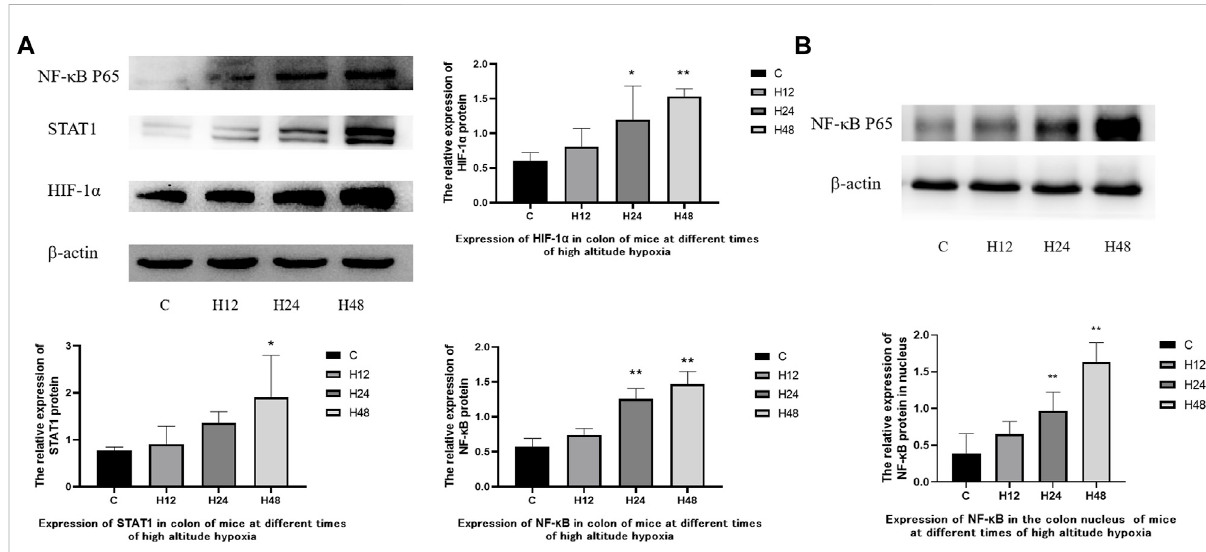
FIGURE 5 Expressionofcolon-associatedproteinsinmiceatdifferenttimesofhigh-altitudehypoxia. (A) Expressionofrelatedproteinsintotalprotein. (B) ExpressionofNF- κ BP65innuclearproteins.1:C,controlgroup;2,H12group,thehigh-altitudegroupfor12 h;3,H24group,thehigh-altitudegroup for 24 h; H48, high altitude group for 48 h, n = 6. The data are presented as the mean ± standard error of the mean. * p < 0.05 vs . N group, ** p < 0.01 vs . C